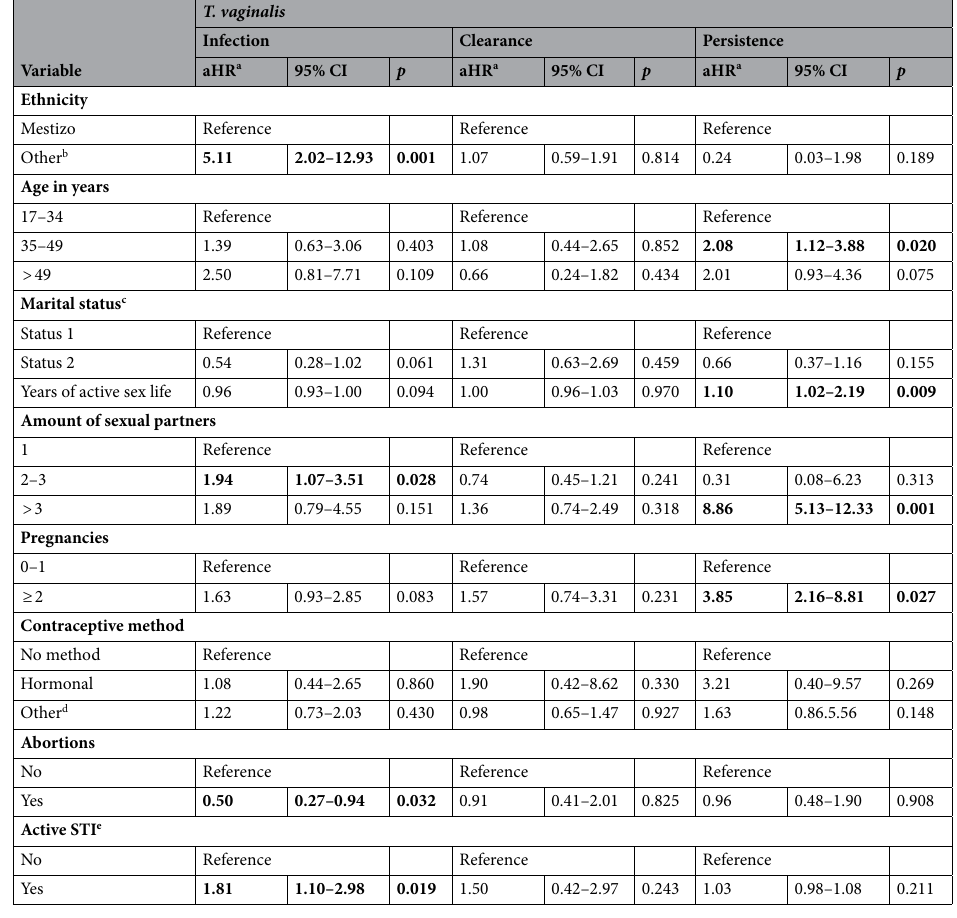
Table 2. Hazard ratio adjusted for modelling the relationship between risk factors and TV-outcome. HR hazard ratio, 95% CI 95% confidence interval, STI sexually transmitted infection. Values in bold indicate p ≤ 0.05. a Hazard ratio adjusted for ethnicity, age, marital status, years of active sex life, amount of sexual partners, pregnancies, contraceptive method used, abortions and active STI. b Ethnicity: the other category includes Afro-descendants and indigenous people. c Marital status: Status 1 included single, separated and widowed women; Status 2 included married women and those in common-law relationships. d Contraceptive method: others includes barrier methods and surgery. e Active STI included the detection of CH, HPV and